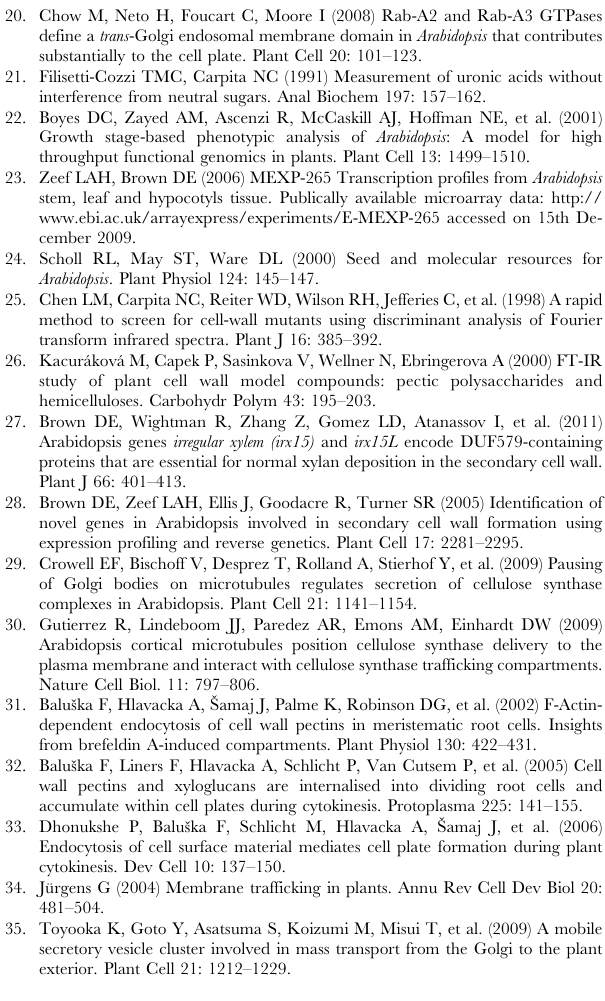
Figure S2 Confirmation of gene transcript absence by RT-PCR analysis of rabA2 T-DNA knockout lines. Expected size fragments for each reaction are shown in table S2.